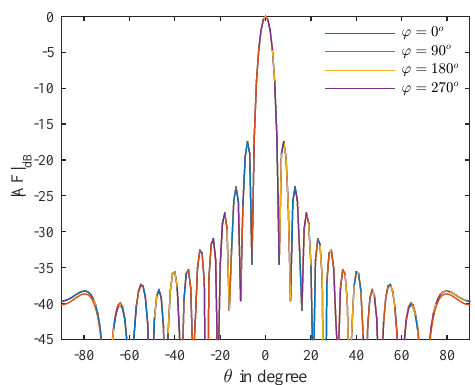
FIGURE 1: Geometry of fully populated CCRAA.